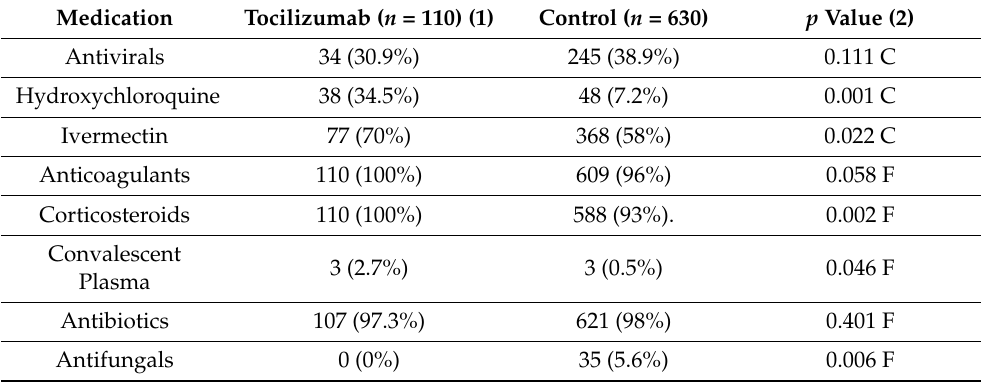
Table 3. Medication administered during hospitalization to the study population.